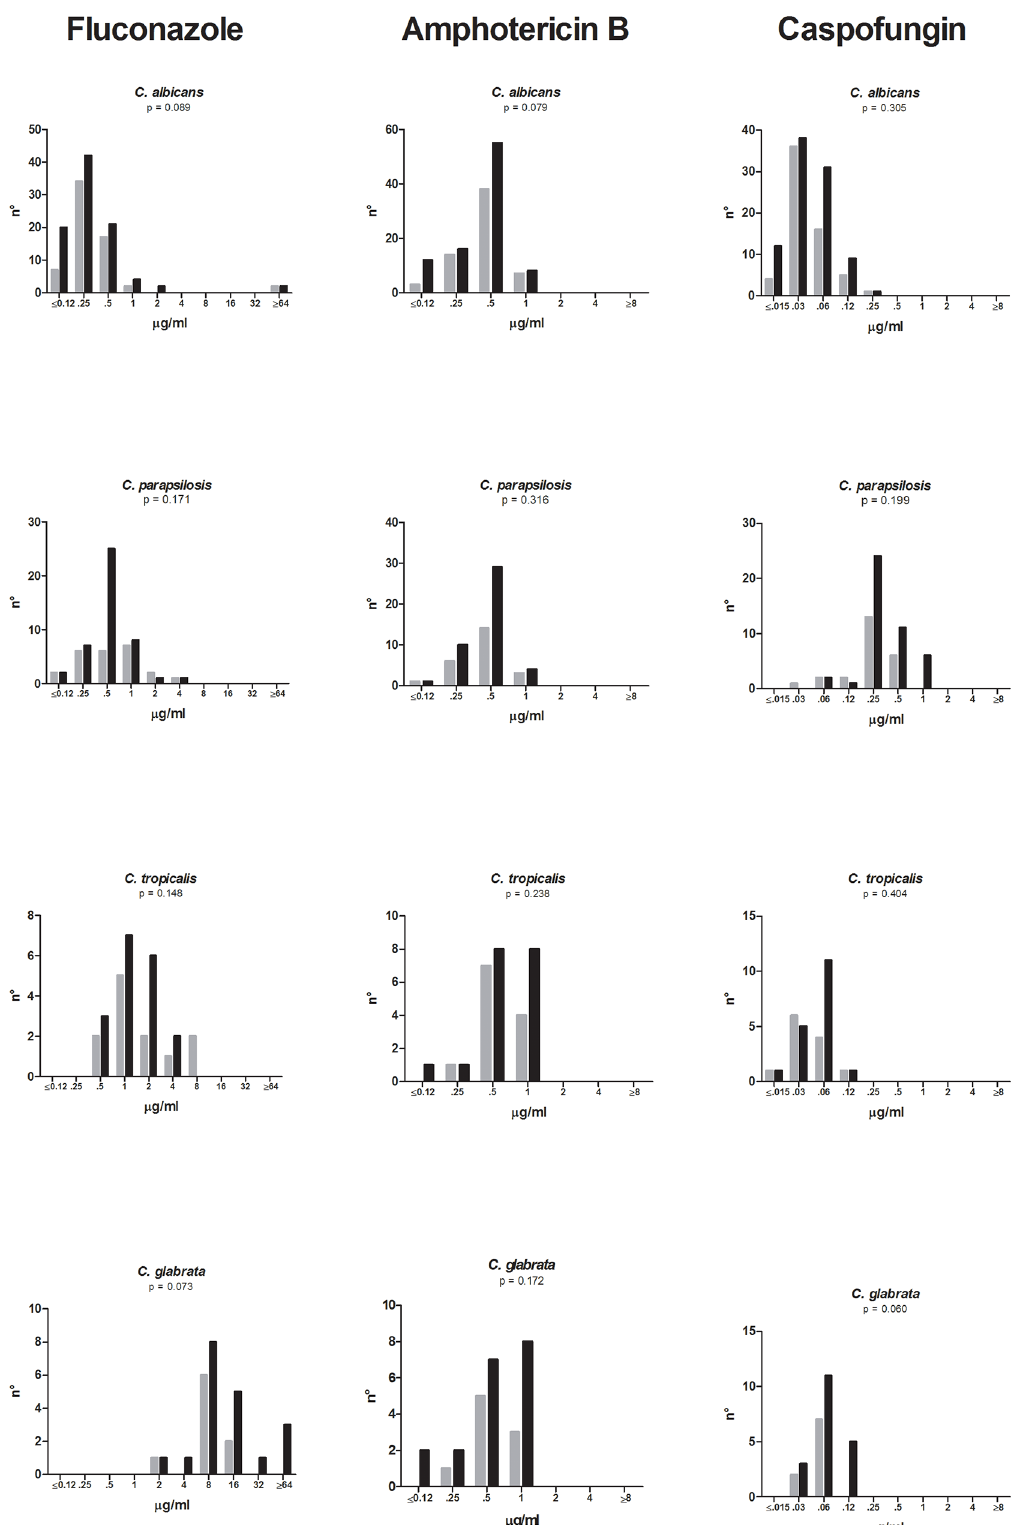
Fig 2. Fluconazole (A), amphotericin B (B), and caspofungin (C) MICs for clinicalisolates of Candida spp. recovered from younger(gray bars) and older (black bars) patients.